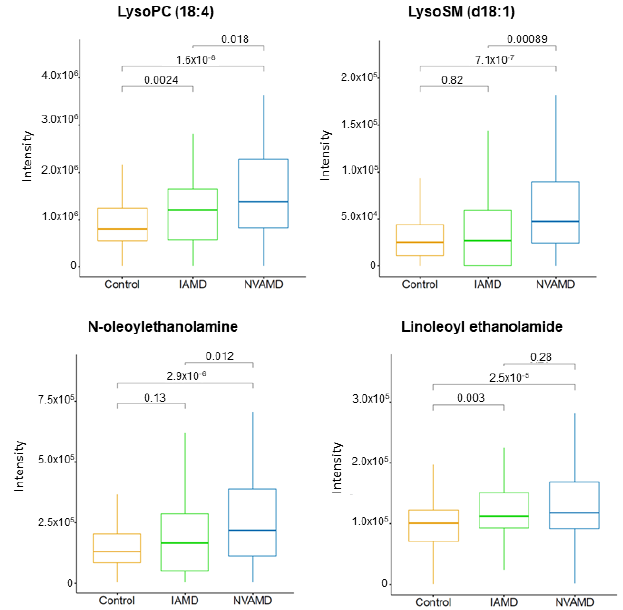
Figure 3. Plasma lipid metabolites altered in AMD patients. Plasma levels of LysoPC (18:4) and LysoSM (d18:1) were higher in NVAMD patients compared with IAMD patients or controls Plasma levels of N-oleoylethanolamine and linoleoyl ethanolamide were higher in NVAMD patients com- pared to controls. Kruskal–Wallis tests were used for pairwise comparisons and p -values are shown above comparison brackets. The molecular identities of these metabolites have been confirmed at MSI level 1 or 2.